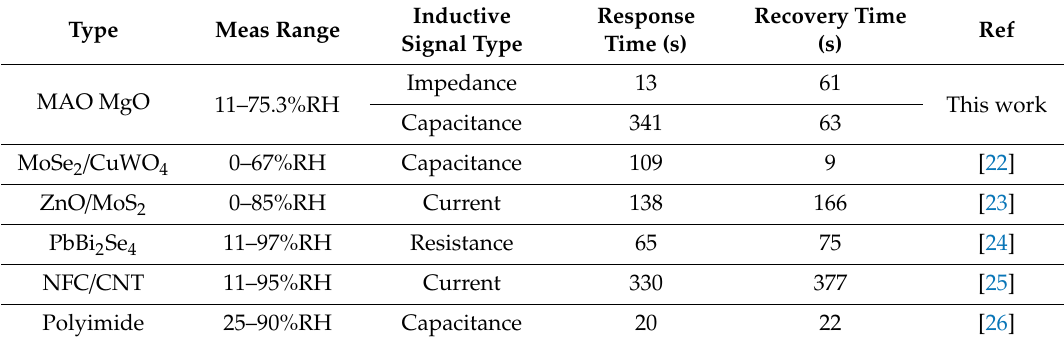
Table 1. Response and recovery time of several moisture-sensitive materials.